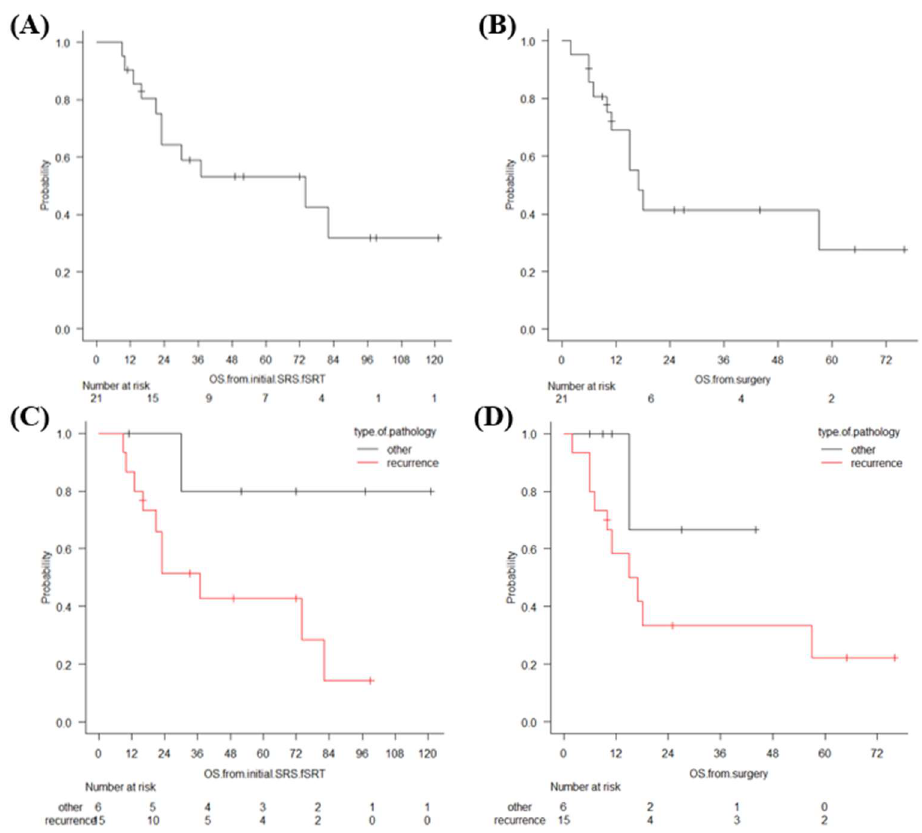
Figure 1. Overall survival time since initial SRS/fSRT ( A ) and overall survival since SSR ( B ), esti- mated using the Kaplan–Meier method. Overall survival time since initial SRS/fSRT ( C ) and since SSR ( D ) in the recurrence group and in RN/cyst formation, estimated using the Kaplan–Meier method.